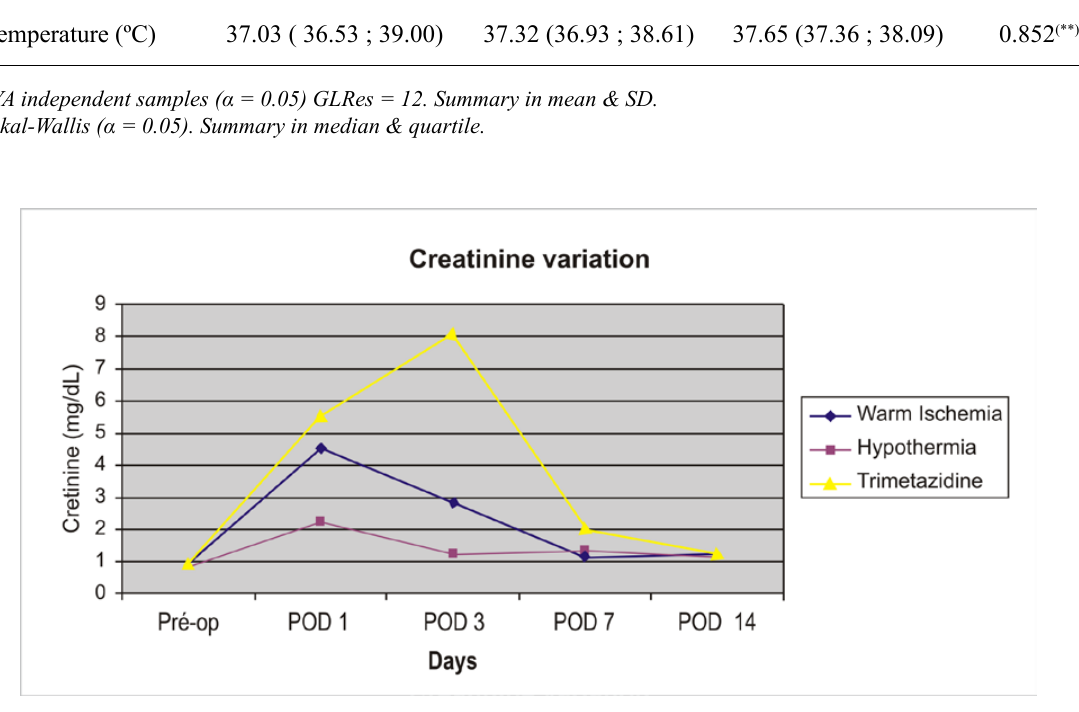
Figure 1. Increase of creatinine values on POD1, POD3 and return to baseline values on